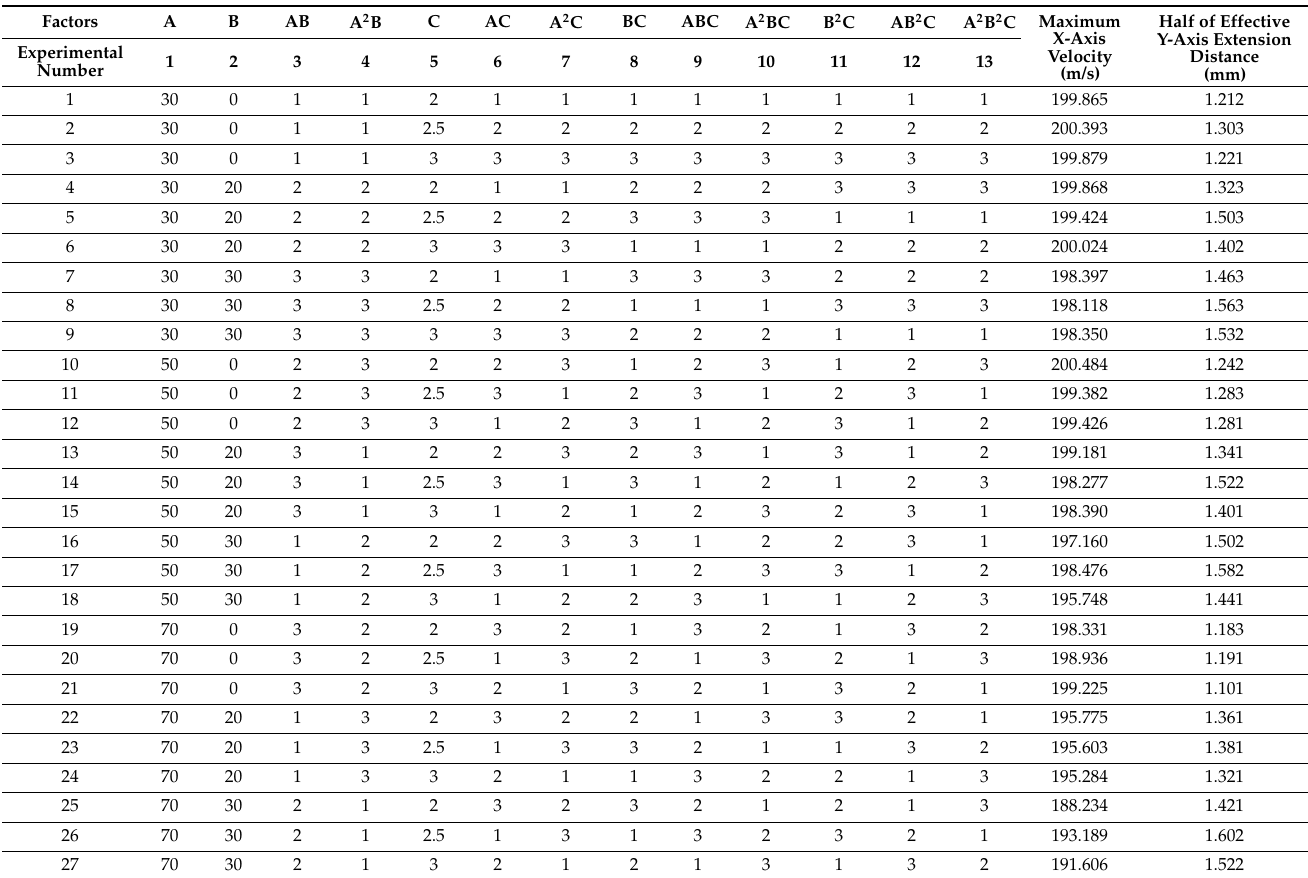
Table 4. Orthogonal experiment table L 27 (3 13 ) and experimental data.